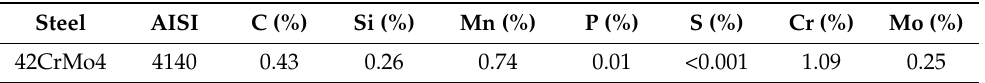
Table 1. Chemical composition of steel specimens.